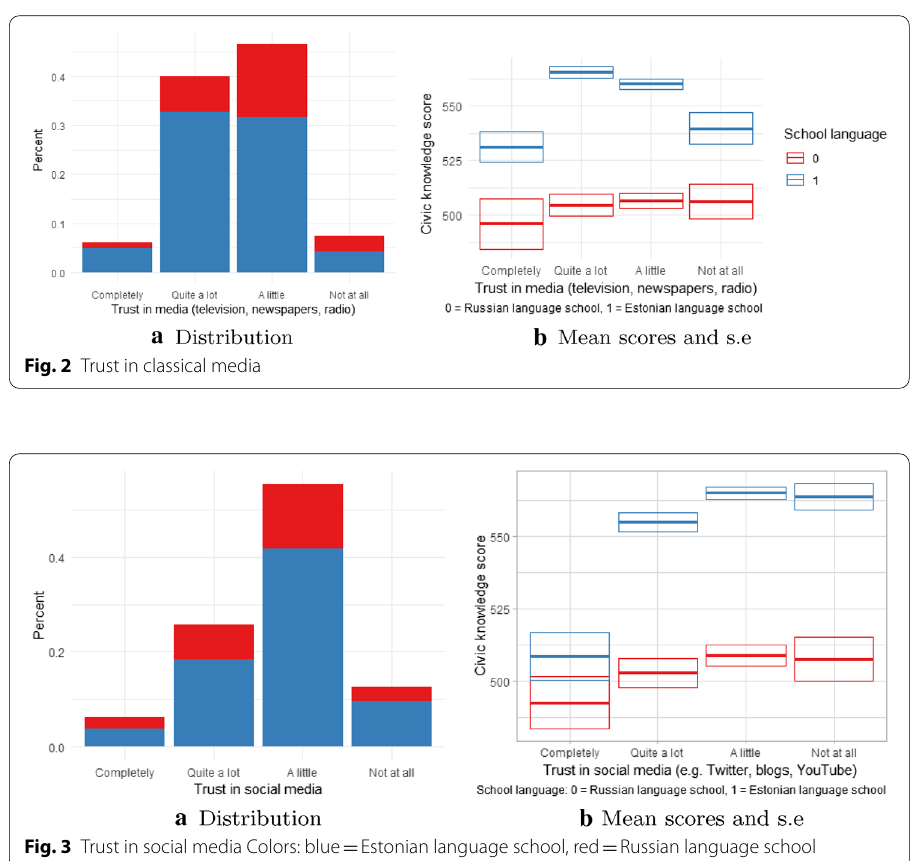
Fig. 3 Trust in social media Colors: blue